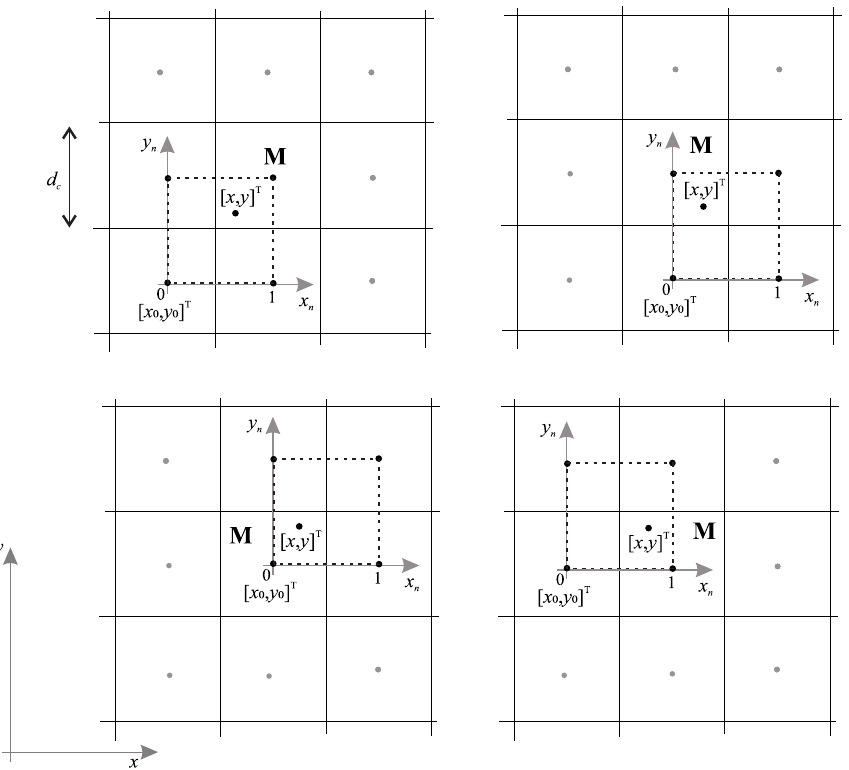
Figure 2. Basis of bilinear interpolation. Interpolated potential at a given point [ x , y ] T is defined by the discrete potential at centres (black dots) of four cells connected by the dashed square. Gray dots denote centres of